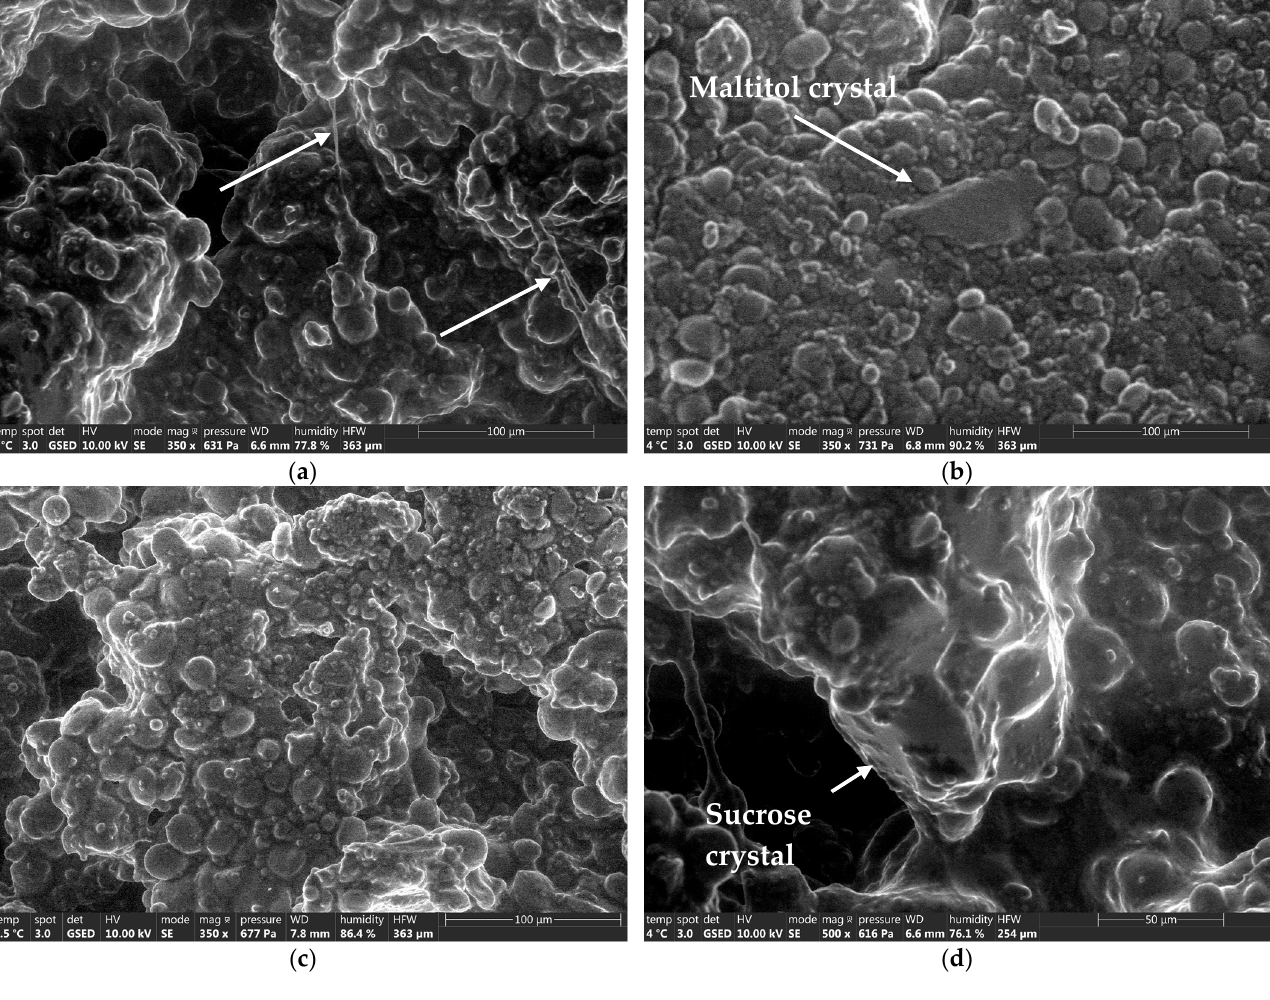
Figure 4. Environmental Scanning electron microscope (ESEM) analyses of dough pieces resulting from the different formulations. ( a ): sucrose dough piece exhibiting an aerated matrix and gluten filaments (white arrows) G × 350, ( b ): maltitol dough exhibiting a compact matrix with embedded maltitol crystals (white arrow) G × 350, ( c ): sorbitol dough exhibiting a compact matrix, no sorbitol fl akes were observed at this stage of the process G × 350, ( d ): ESEM zoom on sucrose crystal embed- ded in the dough matrix (white arrow) G × 500.